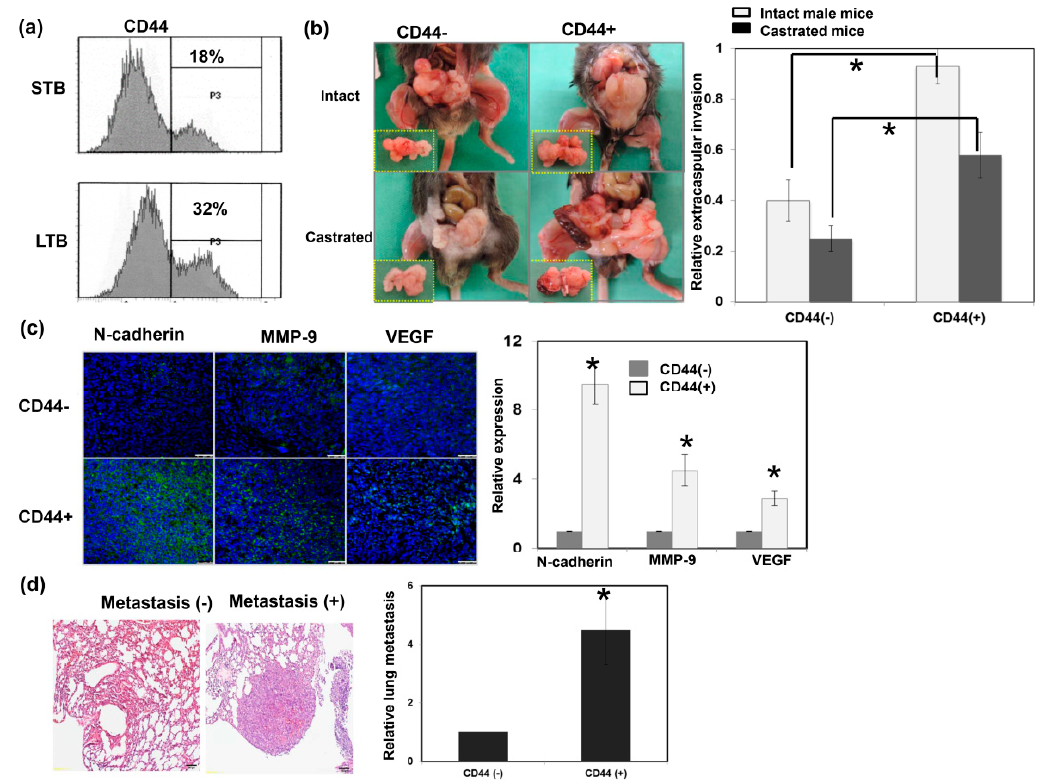
Figure 3. Role of CD44 in tumor aggressiveness. ( a ) The levels of CD44 were evaluated by fluorescence-activated cell sorting (FACS) for cancer cells of LTB compared to those of STB. ( b ) The invasive capacity was evaluated using orthotopic tumor model. The representative slides and quantitative data are shown. The Y -axis represents the ratio of mice presenting extracapsular extension normalized to that received orthotopic tumor implantation. Data points represent the means ± SEMs. *, p < 0.05. ( c ) Expressions of EMT-related proteins were examined by immunofluorescence (IF) in vitro (DAPI, blue; N-cadherin / VEGF / MMP-9, green). Scale bars: 50 µ m. The quantification is to calculate the value of the cell number positive for targeted protein divided by the total cell number. The Y -axis represents the ratio normalized by the value of CD44 ( − ) cells. ( d ) Lung metastasis was determined by cells injected into mice via the tail vein and metastasis assayed. The representative slides and quantitative data are shown. *, p <